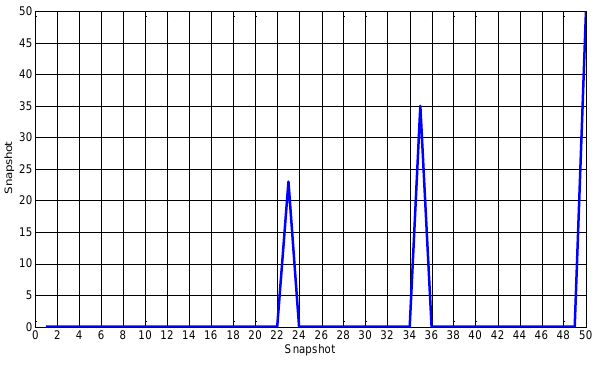
Fig.12 . The number of erroneous snapshots (experiment 1,